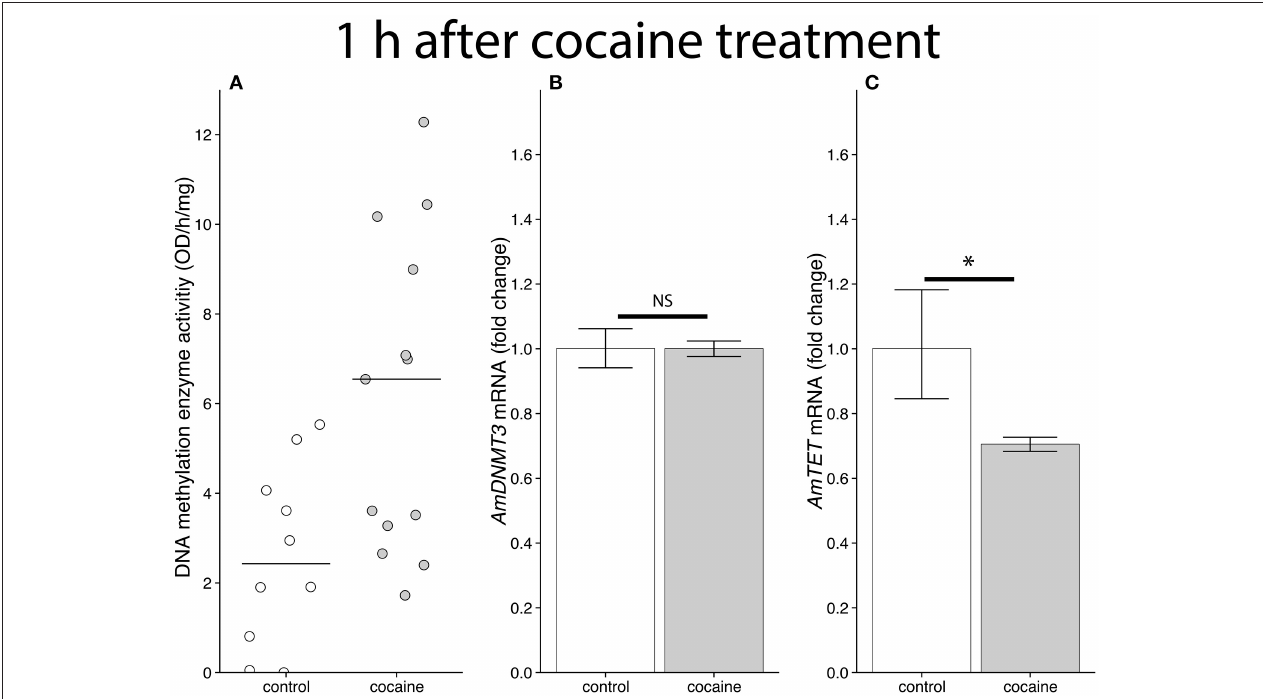
FIGURE 6 | The effects of cocaine on DNA methylation enzyme activity and AmDNMT3 and AmTET and transcription levels, 1h after cocaine treatment. (A) DNA methylation enzyme activity following cocaine administration is displayed as a function of relative optic density. Black lines show median values, dots represent values for samples consisting of four pooled brains. DNMT activity was significantly increased following exposure to 3 µ g of cocaine (Mann-Whitney U = 29, p = 0.01276, r = 0.4994). (B) There was no significant difference in AmDNMT3 mRNA levels following cocaine or control treatments ( AmUGT : t 10 = 1.3439, p = 0.1940; AmeIF.S8 : t 10 = 0.0001, p = 0.9999). (C) There was a significant reduction in levels of AmTET mRNA in bees treated with cocaine ( AmUGT: t 10 = − 5.0172, p < 0.0001, d = − 1.5866; Ame.IF.S8 : t 10 = − 5.3780, p < 0.0001, d = − 1.7007). *Denotes statistically significant